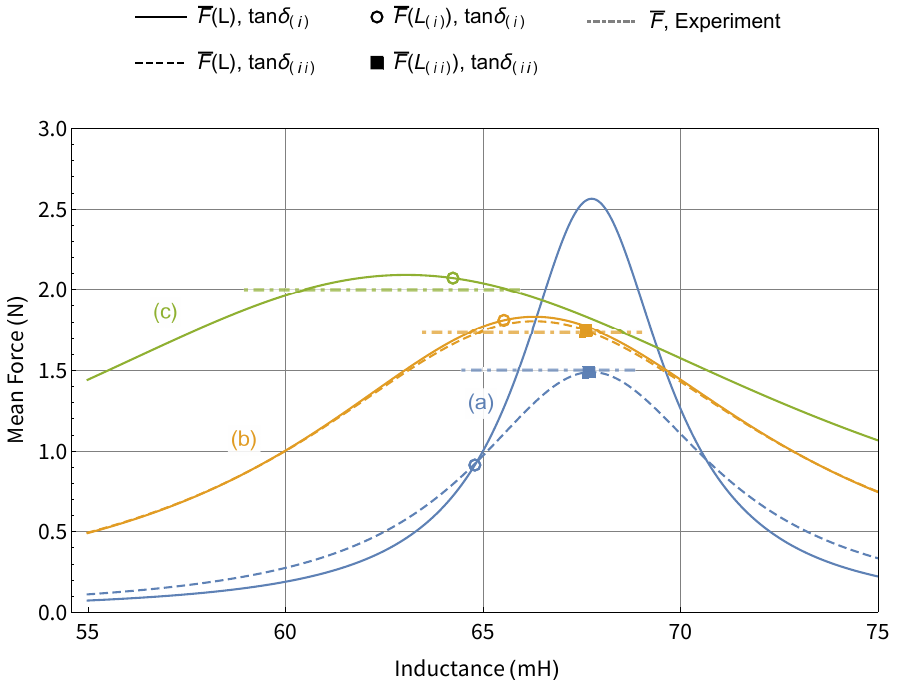
Figure 11. Comparison of mean force output against inductance, considering different sets of model